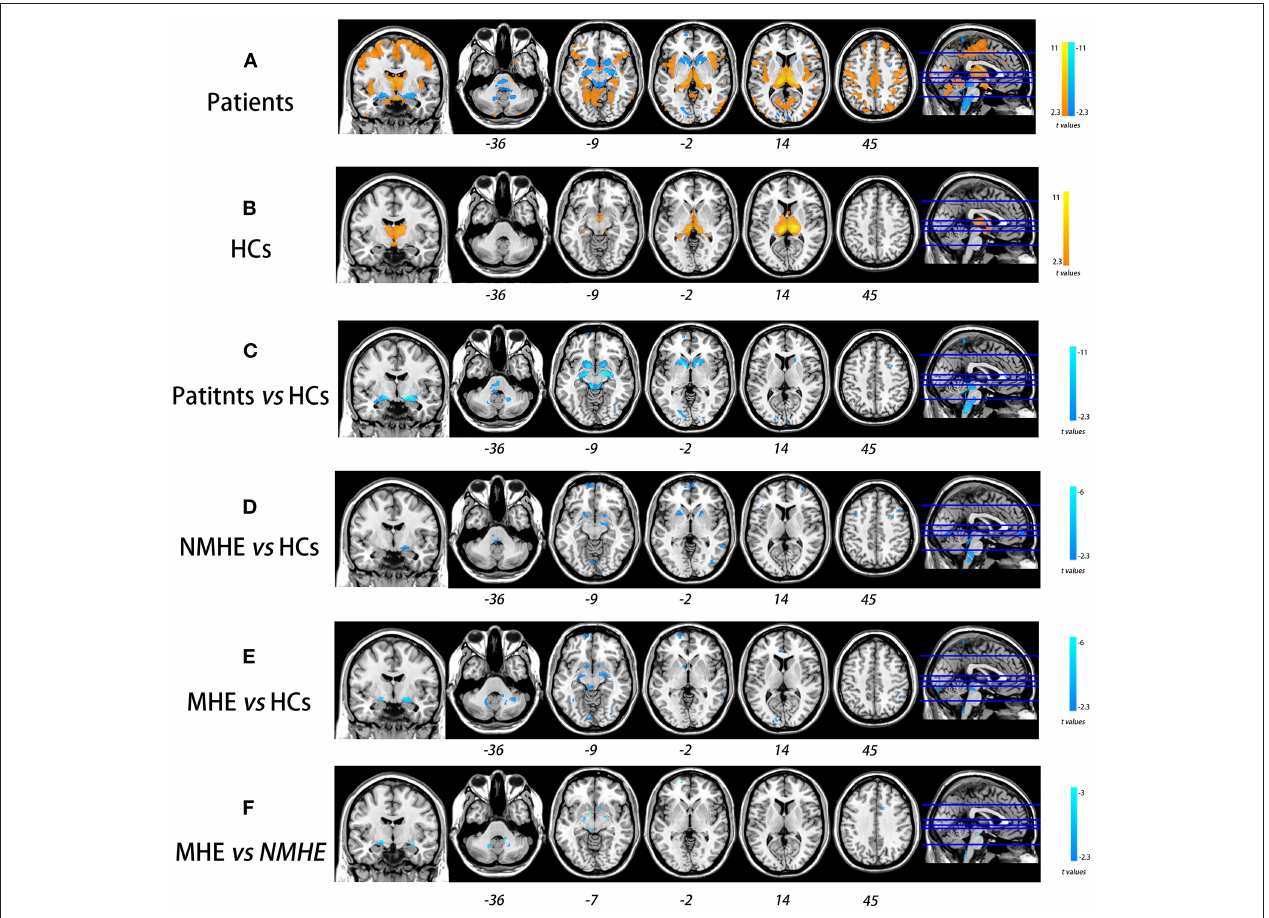
FIGURE 6 | Progressive deterioration of the thalamus-associated structural covariance network (SCN) in HBV-RC patients. Both HC and HBV-RC patients exhibited positive synchronous SCN between the thalamus and cortex (A,B) . In HBV-RC patients, negative synchronous SCN between the thalamus and basal ganglia was also observed (B) . The HBV-RC patients exhibited enhanced negative synchronous SCN between the thalamus and the bilateral basal ganglia as well as the cortex compared with HCs (C) . Furthermore, progressive disruption of thalamus-related SCN was observed in HBV-RC patients as the disease advanced. Specifically, in the NMHE stage, patients showed increased negative synchronization between the basal ganglia and cortex compared to HCs ( p < 0.01, corrected, D ), and in the MHE stage, the negative synchronization between the thalamus and basal ganglia increased further compared to HCs (E) and NMHE patients (F) . The color bar represents the t -values. HCs, healthy controls; NMHE, patients without MHE; MHE, minimal hepatic